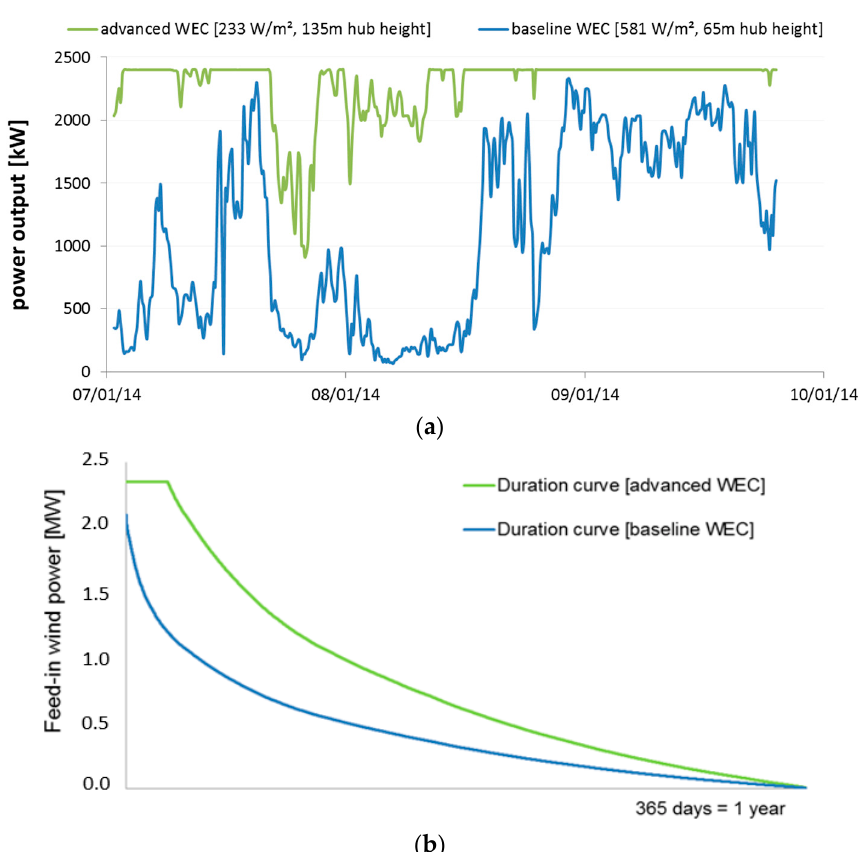
Figure 1. Comparison of the time series for power production based on actual wind and performance data from a wind farm in Germany ( a ) and generalized feed-in duration curves for baseline and advanced wind energy converters (WEC) ( b ).